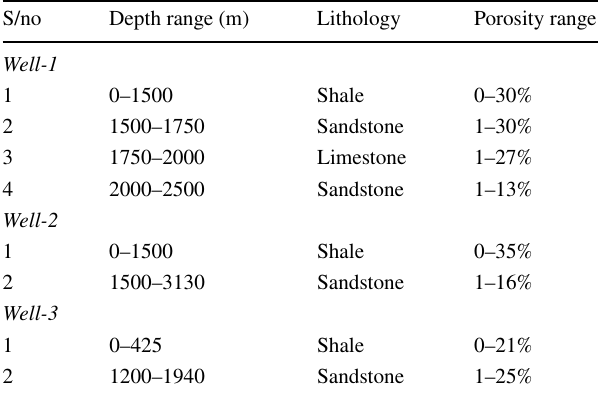
Table 2 Porosity with their corresponding lithologies and depths in each